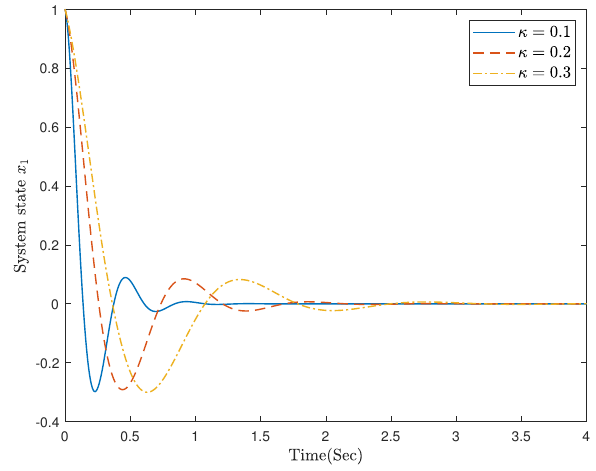
Figure 3. The trajectories of system state x 1